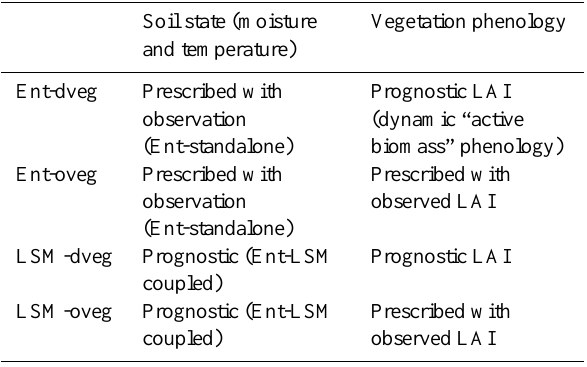
Table 4. Types of